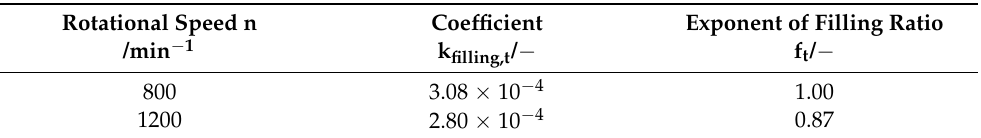
Table 11. Variables for model equation (Equation (18)) to describe the total stressing energy based on the filling ratio ϕ media ( − ) for d media = 10 mm.